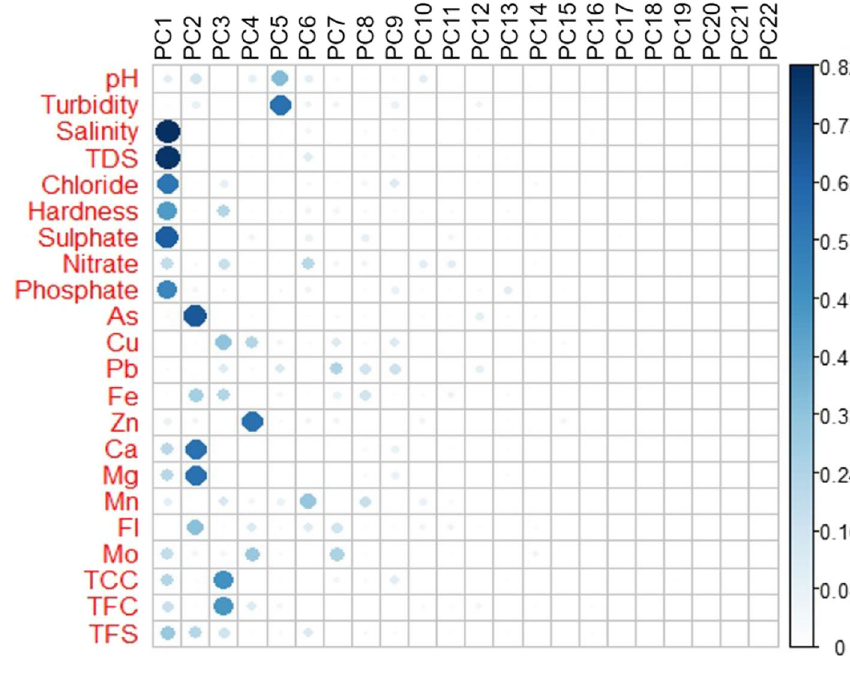
Fig. 3 Variable Loadings in Principal Components